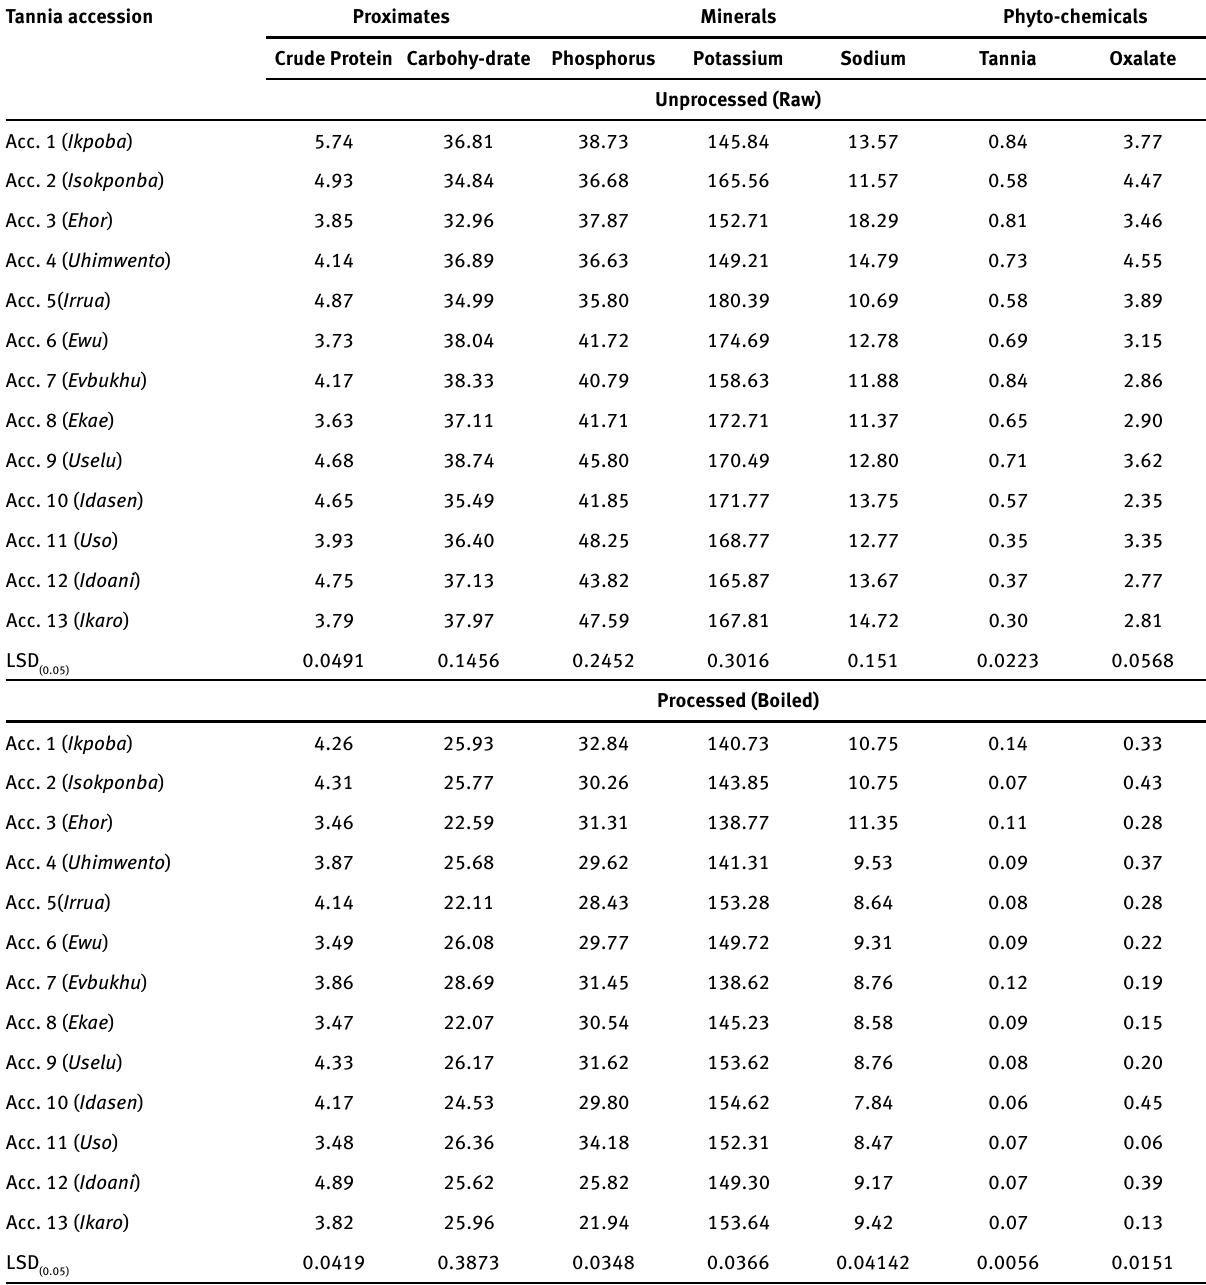
Table 10: Proximate, mineral and phyto-chemical analysis of unprocessed (raw) and processed (boiled) tannia accession corms Tannia